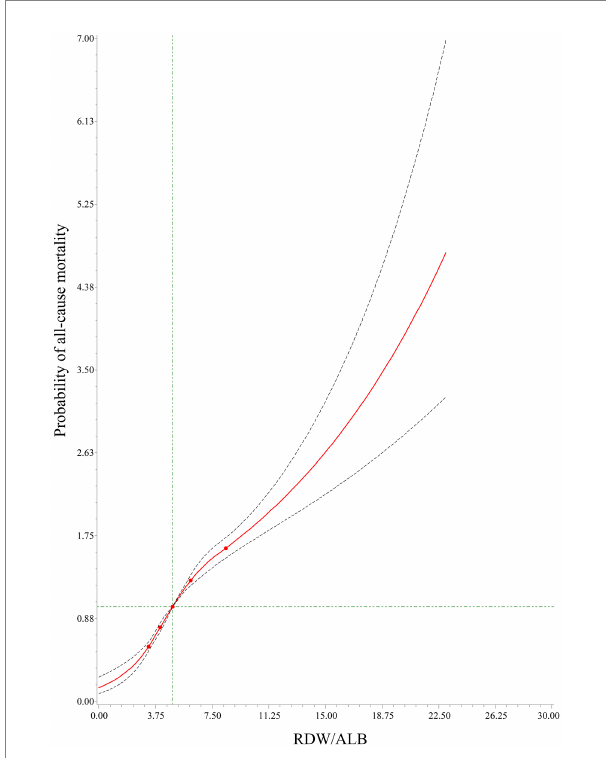
FIGURE 2 The relationship between the red cell distribution width (RDW)/ albumin (ALB) ratio and the crude probability of all-cause mortality using